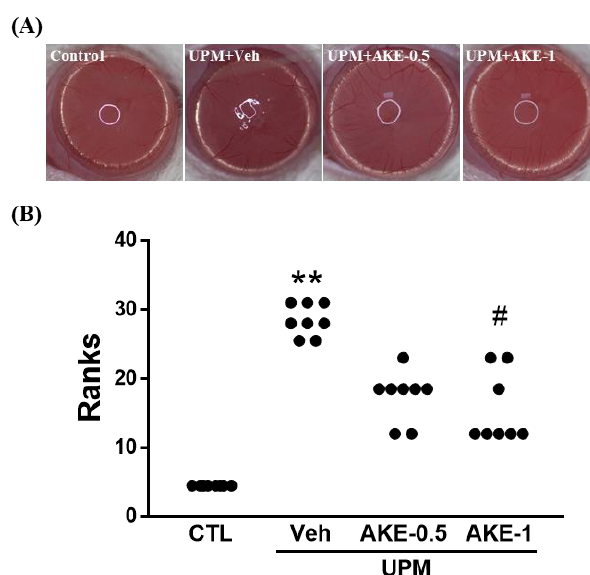
Figure 3. Effects of AKE on corneal irregularity in the UPM exposure-induced KCS model. ( A ) Representative reflected images of a white ring from the fiber-optic ring illuminator of the stereomicroscope. ( B ) Quantitative analysis of the corneal irregularity score. Control group: CTL; vehicle group: Veh; 0.5 mg/mL AKE-treated group: AKE-0.5; and 1 mg/mL AKE-treated group: AKE-1. Data were presented as a median score using a ranks analysis (n ≥ 8). ** p < 0.01 vs. CTL, # p < 0.05 vs. Veh.